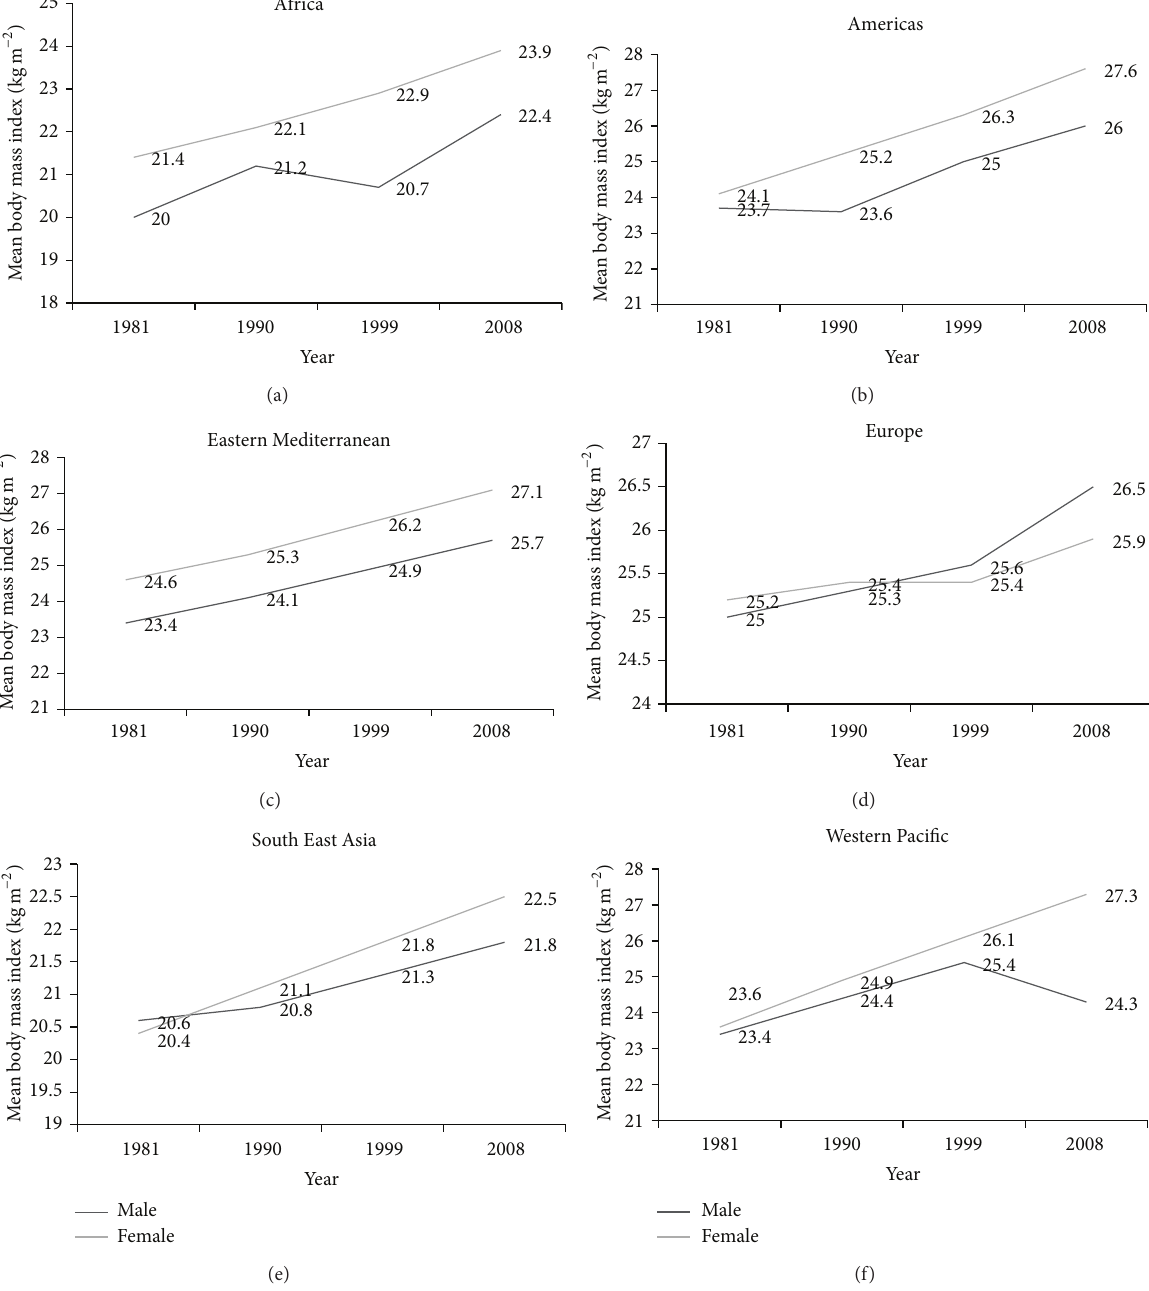
Figure 1: (a) Mean body mass index trends (age-standardised estimate) in Africa. (b) Mean body mass index trends (age-standardised estimate) in America. (c) Mean body mass index trends (age-standardised estimate) in Eastern Mediterranean. (d) Mean body mass index trends (age-standardised estimate) in Europe. (e) Mean body mass index trends (age-standardised estimate) in South East Asia. (f) Mean body mass index trends (age-standardised estimate) in Western